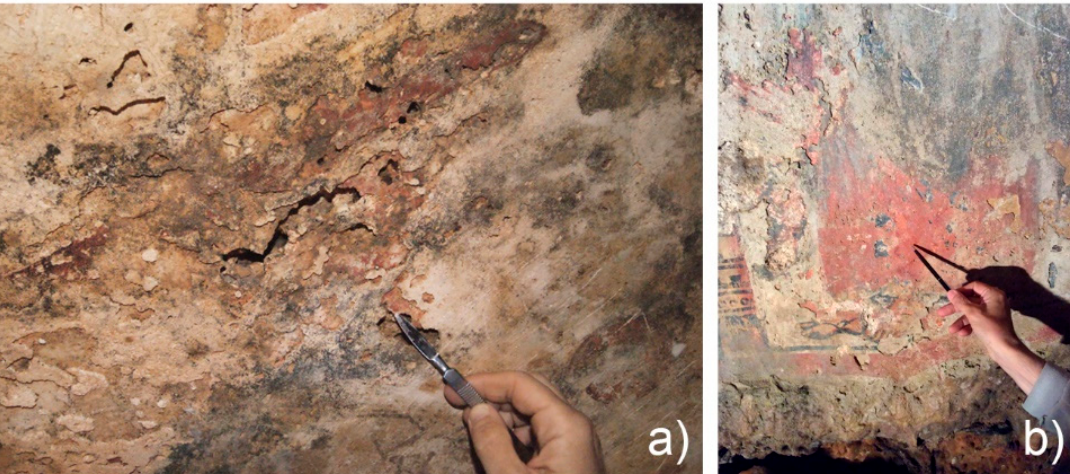
Figure 9. Degradation effects on the surface of wall paintings in the Sant’Angelo crypt: ( a ) losses and calcite deposits on the surface of “Descent of the Holy Spirit and Christ Pantocrator” painting; ( b ) dark deposit on the surface of “The Virgin and the Child flanked by the St. John and the St. Michael” painting.